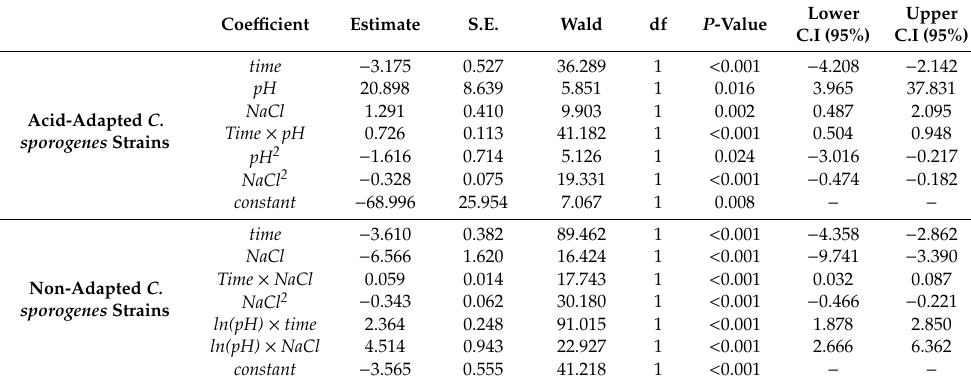
Table 2. Parameter estimates of the logistic regression models for the acid-adapted and non-adapted C. sporogenes strains.